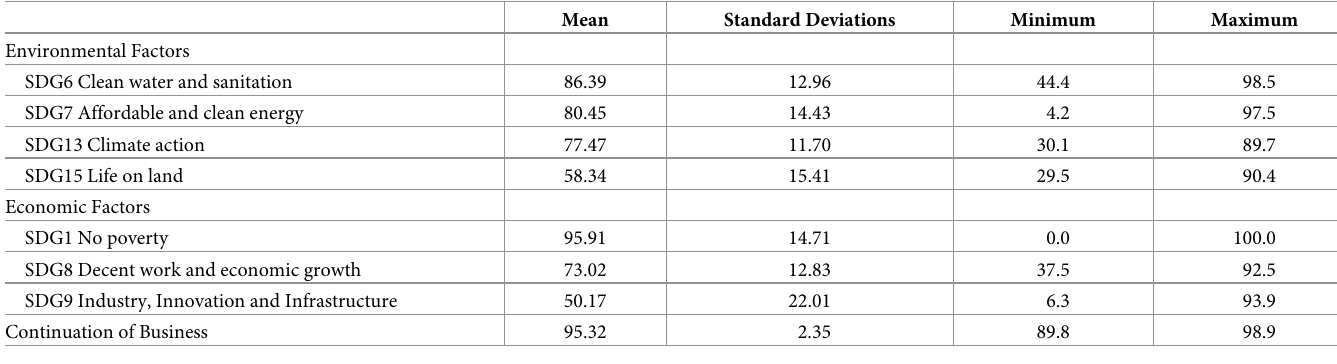
Table 2. Descriptive